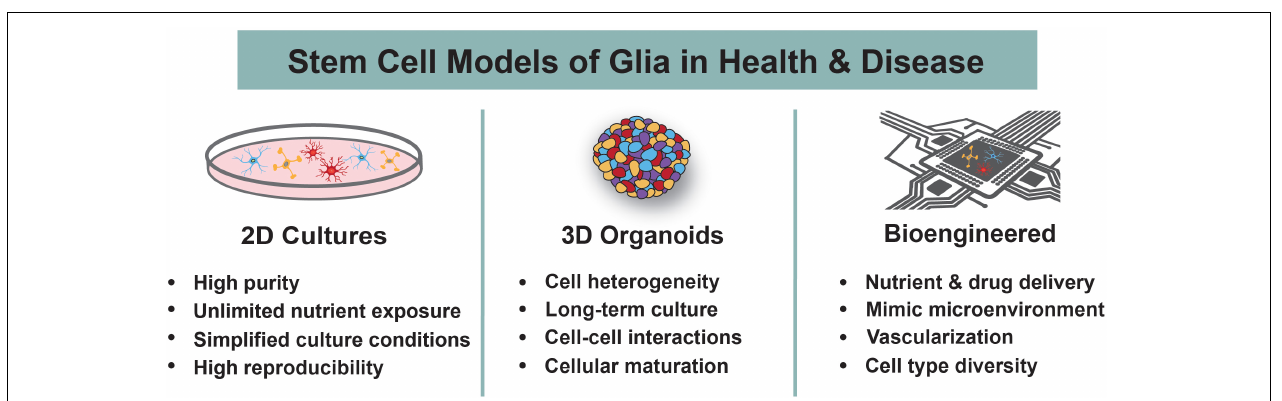
FIGURE 2 | Human Stem Cell Models to Study Glia. Human stem cells are differentiated into astrocytes, oligodendrocytes, and microglia using 2D cultures, 3D organoids, or bioengineered systems. The main advantages of each system are highlighted. These models are used to understand the roles of glia during normal development and in the context of neurodevelopmental